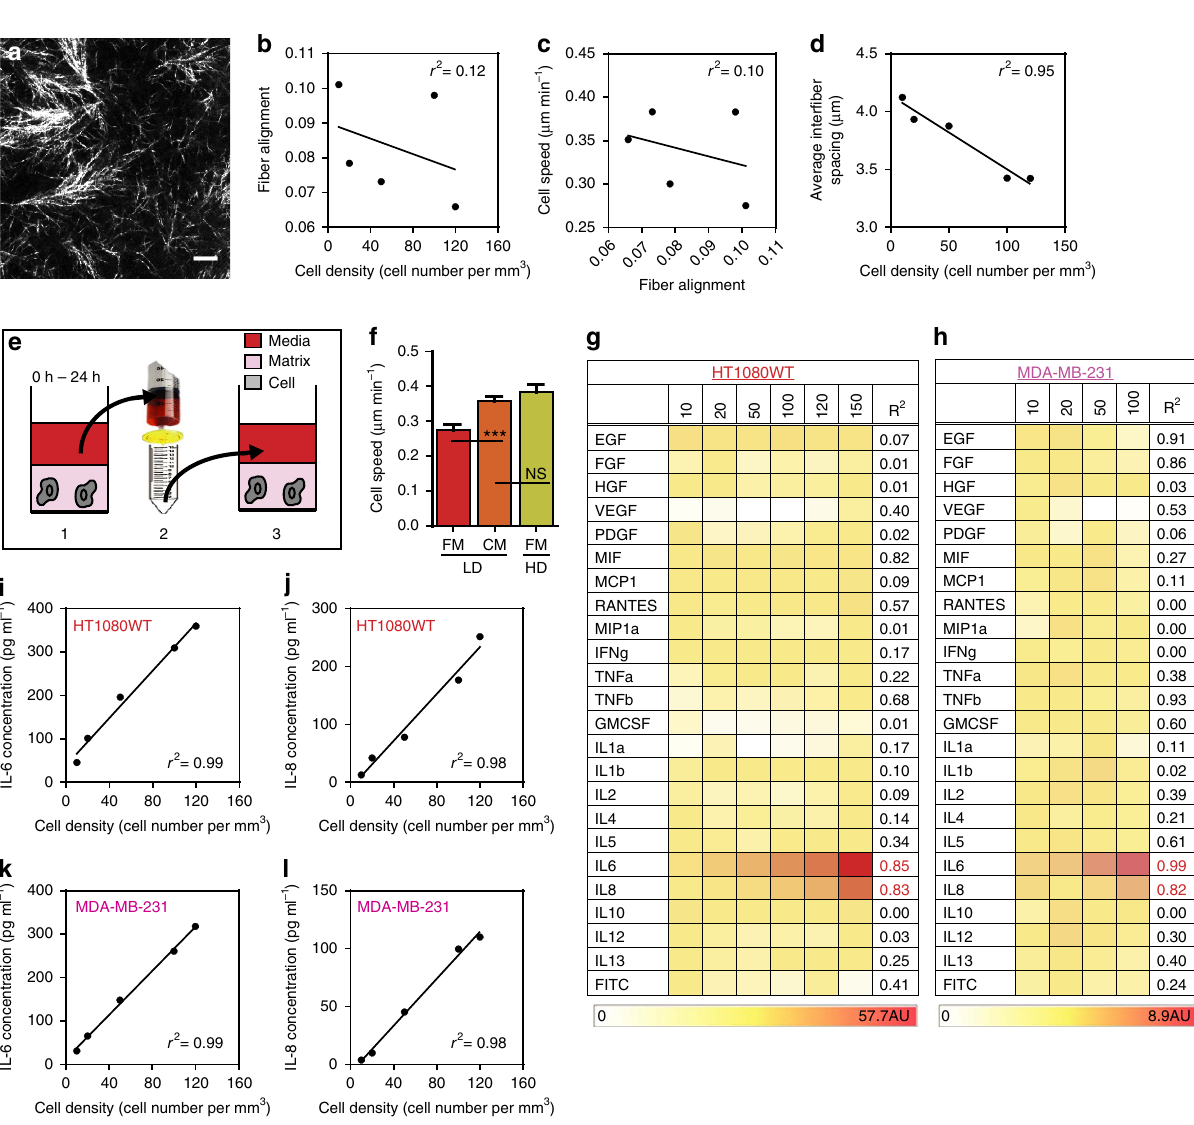
(Fig. 2e,f). This result suggests that soluble molecules secreted by matrix embedded cancer cells are sufficient to promote enhanced cell migration.